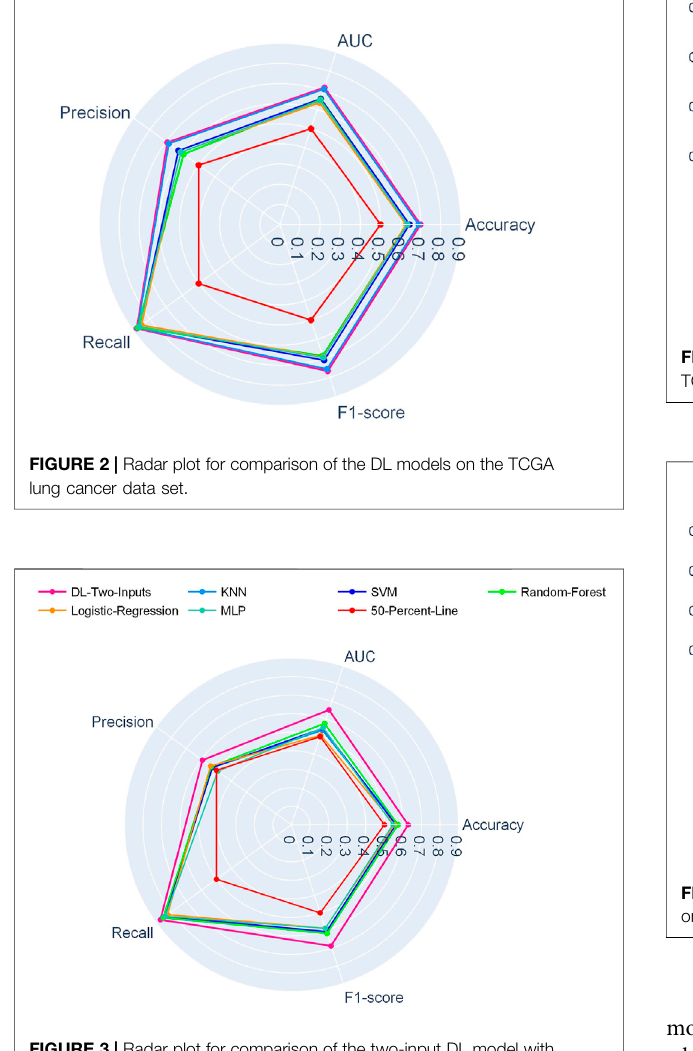
FIGURE 3 | Radar plot for comparison of the two-input DL model with the ML models on the TCGA lung cancer data set.